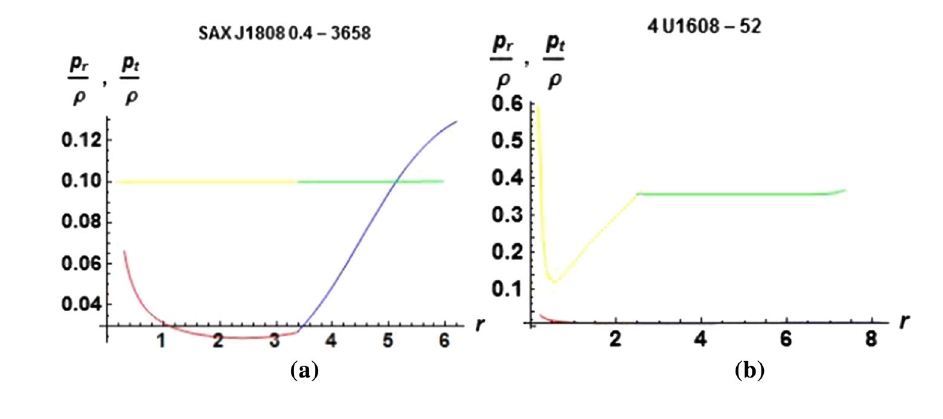
Fig. 5 variation of mass with radial coordinate